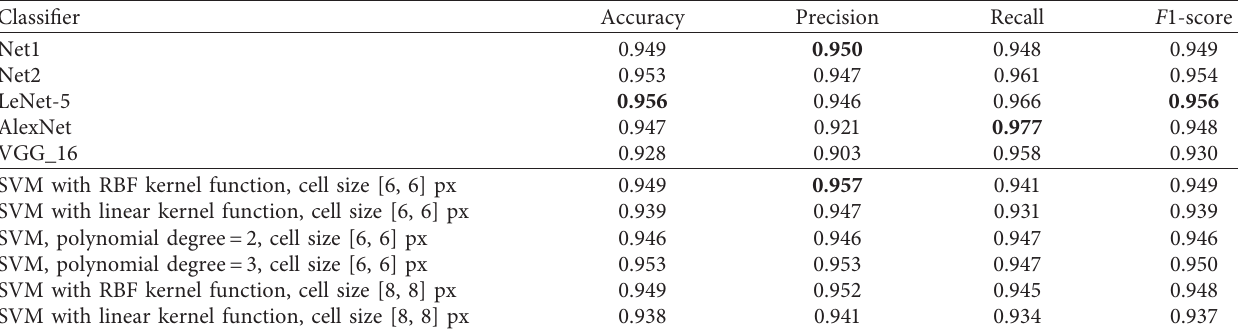
Figure 11: Boxplot representation of loss function values ( y -axis) obtained by validation of the HOG-based passenger recognition system. Results are displayed in separate graphs with respect to used kernel function. In each graph, the data are grouped according to the sizes of cells ( x -axis). Table 3: Evaluation of classification performance of ConvNet-based (first section) and HOG-based (second section) passenger recognition systems using the measures